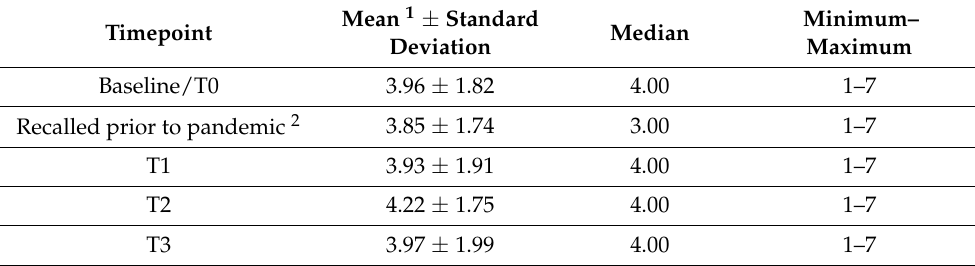
Table 4. Descriptive statistics for headache frequency by timepoint.